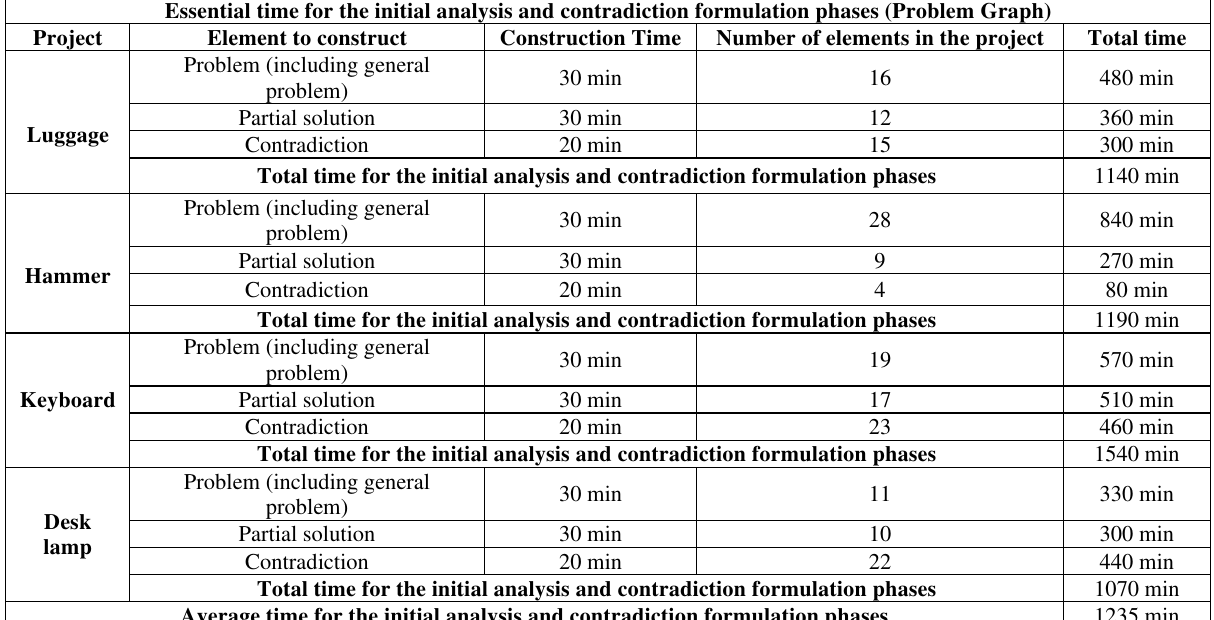
Table 1: Information Collected from four different student projects Essential time for the initial analysis and contradiction formulation phases (Problem Graph)